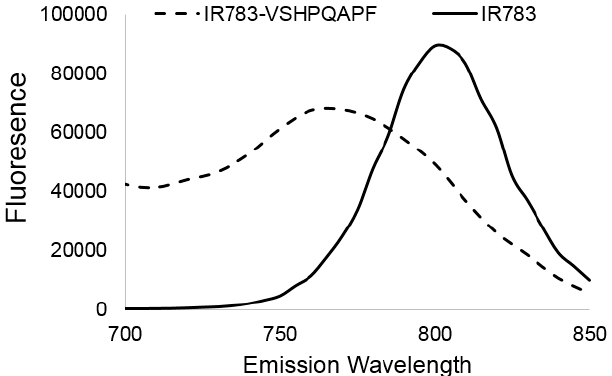
Figure 2. Fluorescence spectra of IR783 (solid line) and IR783 covalently linked to VSHPQAPF (dashed line) showing blue shift in the emission peak.